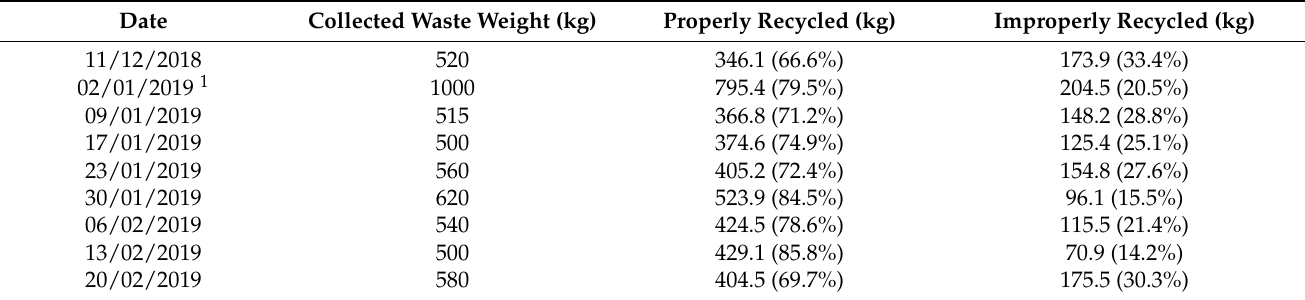
Table 3. Number of participating families per municipality in the